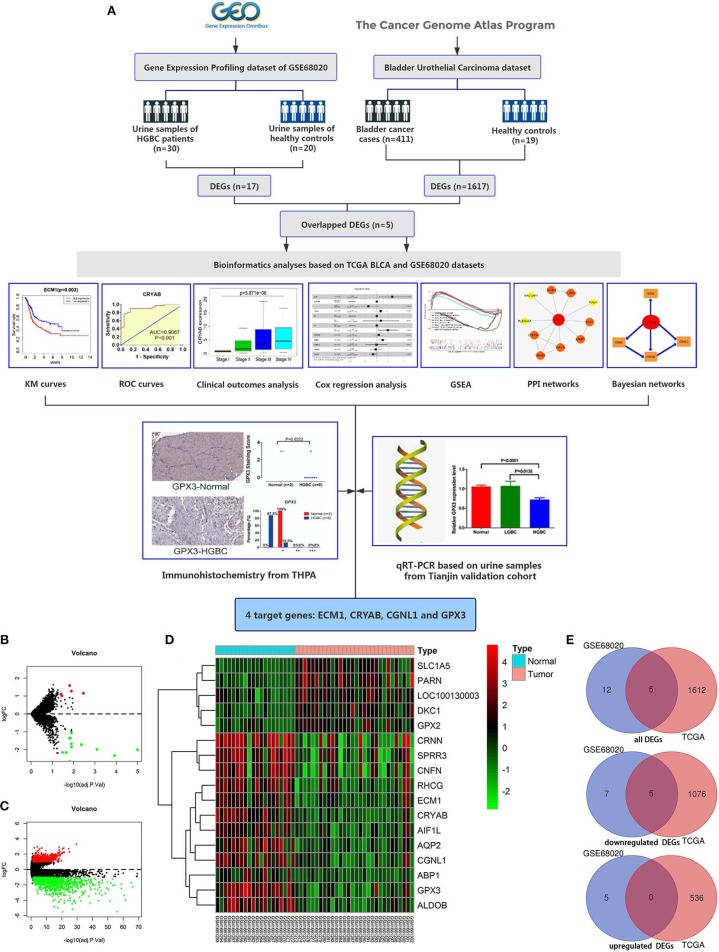
Workflow of this study and identification of differentially expressed genes (DEGs) based on GEO GSE68020 and TCGA BLCA datasets. (A) Workflow of this study; (B) Volcano plot for GSE68020 dataset; (C) Volcano plot for TCGA BLCA dataset; (D) Heat map for DEGs of TCGA BLCA dataset; and (E) Venn diagram for overlapped DEGs. Permissions to use the logo of GEO (Gene Expression Omnibus) have been obtained from the copyright holders of GEO. GEO, Gene Expression Omnibus; TCGA, The Cancer Genome Atlas; BLCA, Bladder Urothelial Carcinoma; KM, kaplan-Meier; ROC, receiver operating characteristic; GSEA, gene set enrichment analysis; PPI, protein-protein interaction; THPA, The Human Protein Atlas; qRT-PCR, quantitative real-time polymerase chain reaction.